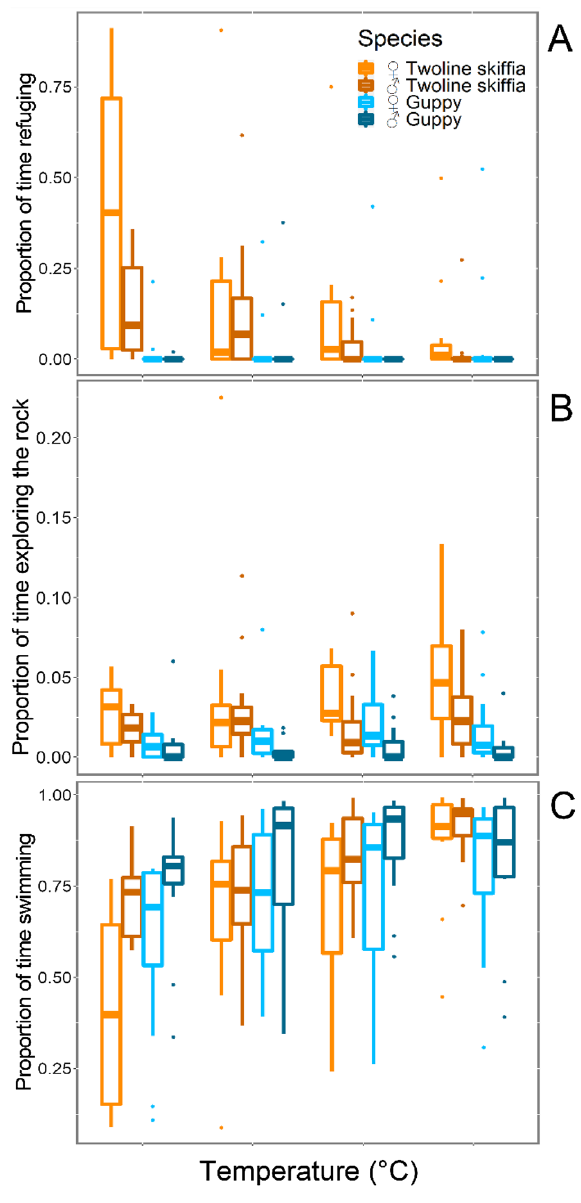
boxes the 50% of the data